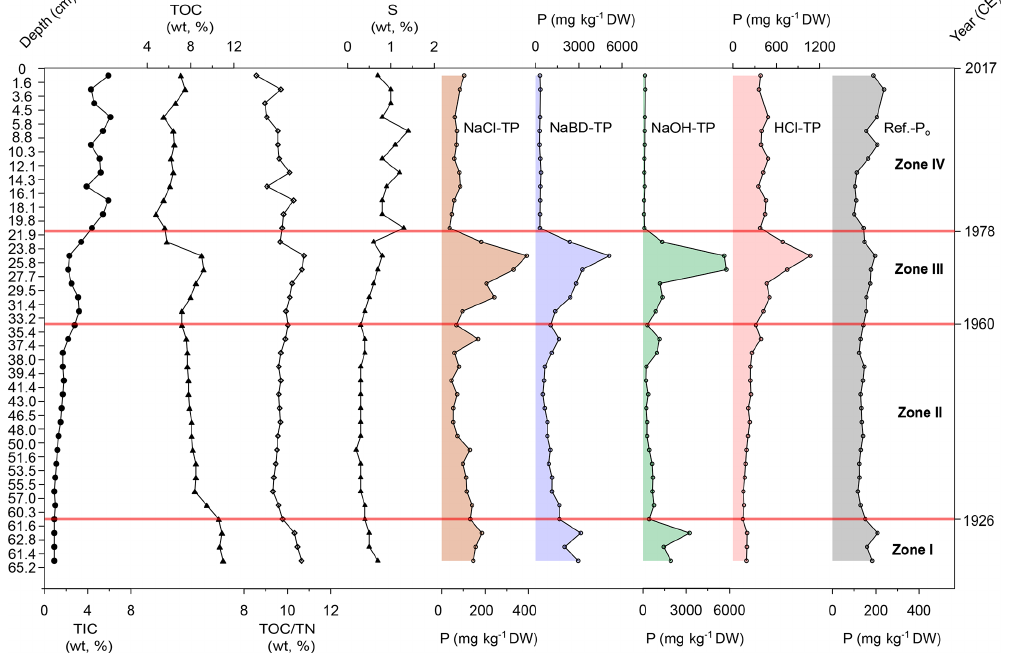
Figure 5. The stratigraphy of total inorganic carbon (TIC), total organic carbon (TOC), sulfur (S) content, the TOC / TN ratio, and five phosphorus fractions in sediments of Lake Burgäschi. The y axis (left) refers to the sediment depth of core Burg17-B. The red horizontal lines separate the significant CONISS zones as in Fig. 3. The secondary y axis (right) indicates approximate ages of sediments inferred from the Burg17-B core chronology.